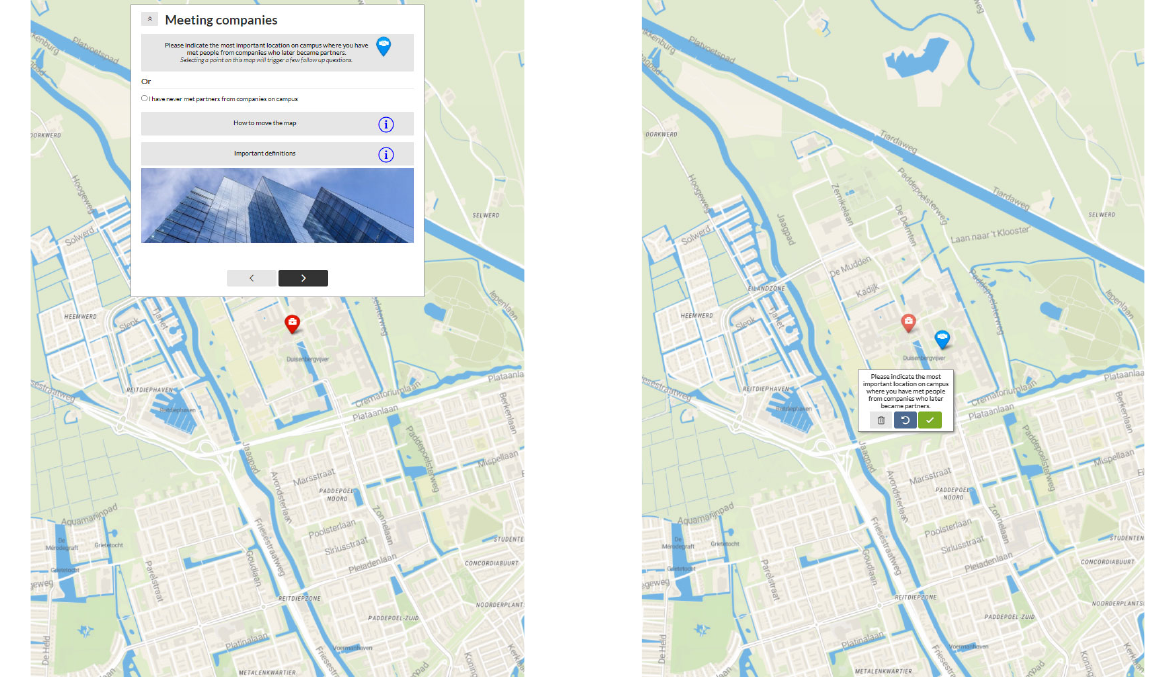
Figure A2. RUG campus—Maptionnaire screenshot: indicating meeting location.